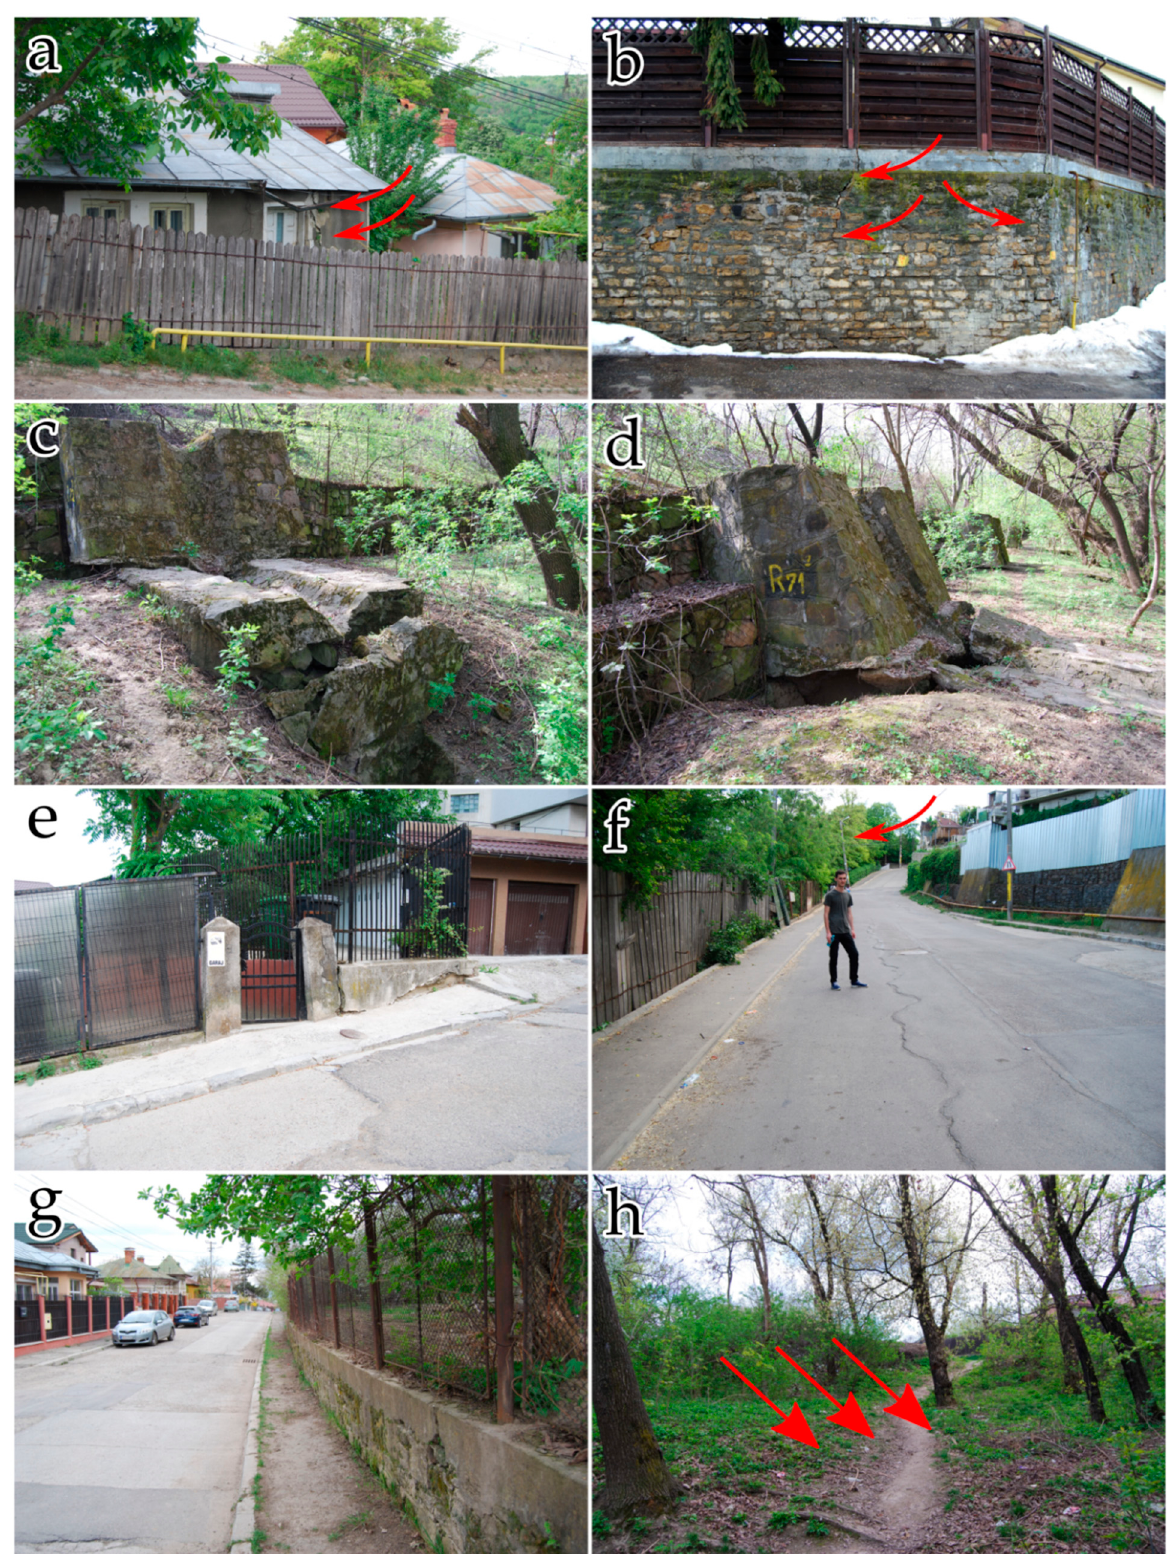
Figure 4. Evidence of surface displacements occurring over the Ț ic ă u landslide affected area. ( a ) Centimeter cracks in the outer wall of a house; ( b ) wall cracks; ( c , d ) damage to stabilizing infrastructure; ( e ) damaged fence; ( f ) roadway cracks and leaned electric pole (red arrow); ( g ) wall bulging; ( h ) tilted trees, red arrows indicate the direction of displacement. (high-resolution image available at https://doi.org/10.6084/m9.figshare.14915250.v1).